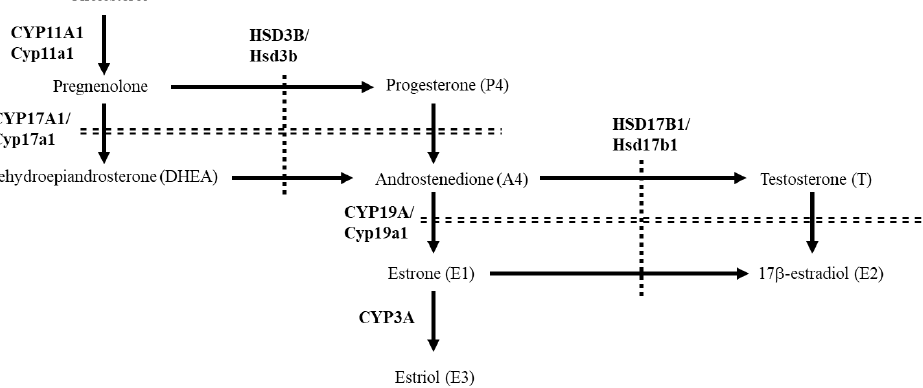
Figure 1. Pathways for producing androgens and estrogens in mammalian ovary and placenta. Human, bovine, ovine, and porcine steroidogenic enzymes are indicated totally by capital letters, whereas rodent counterparts are indicated only initially by a capital letter.